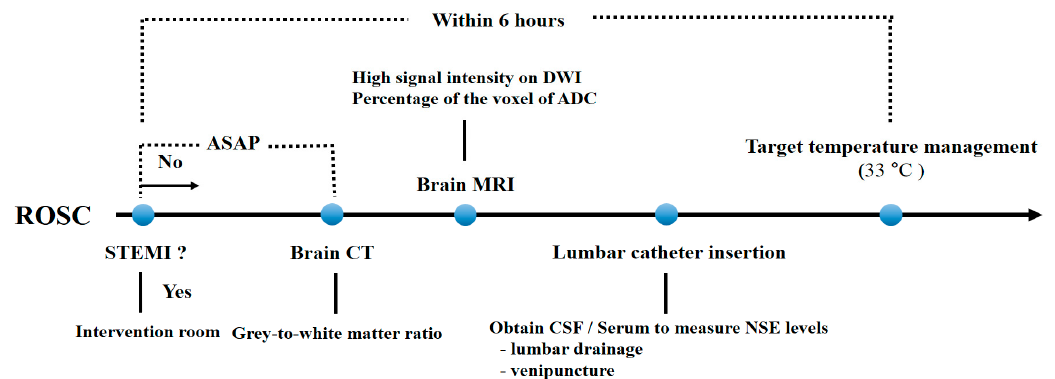
Figure 1. Timeline of examinations and procedures for patients included in this study. Abbreviations: ROSC, return of spontaneous circulation; STEMI, ST-elevation myocardial infarction; ASAP, as soon as possible; CT, computed tomography; MRI, magnetic resonance image; CSF, cerebrospinal fluid; NSE, neuron-specific enolase; DWI, diffusion-weighted imaging; ADC, apparent diffusion coefficient.